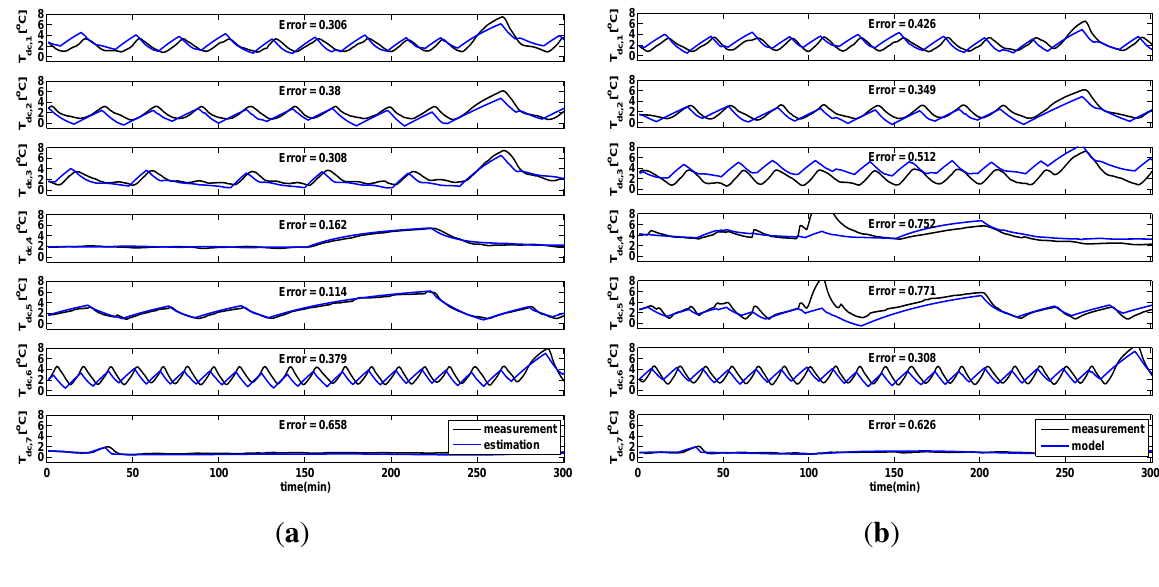
Figure 8. Estimation of display case temperatures after system integration. The estimation error increases slightly due to modeling error associated with each subsystem. ( a ) Estimation using training data; ( b ) Estimation using validation data.